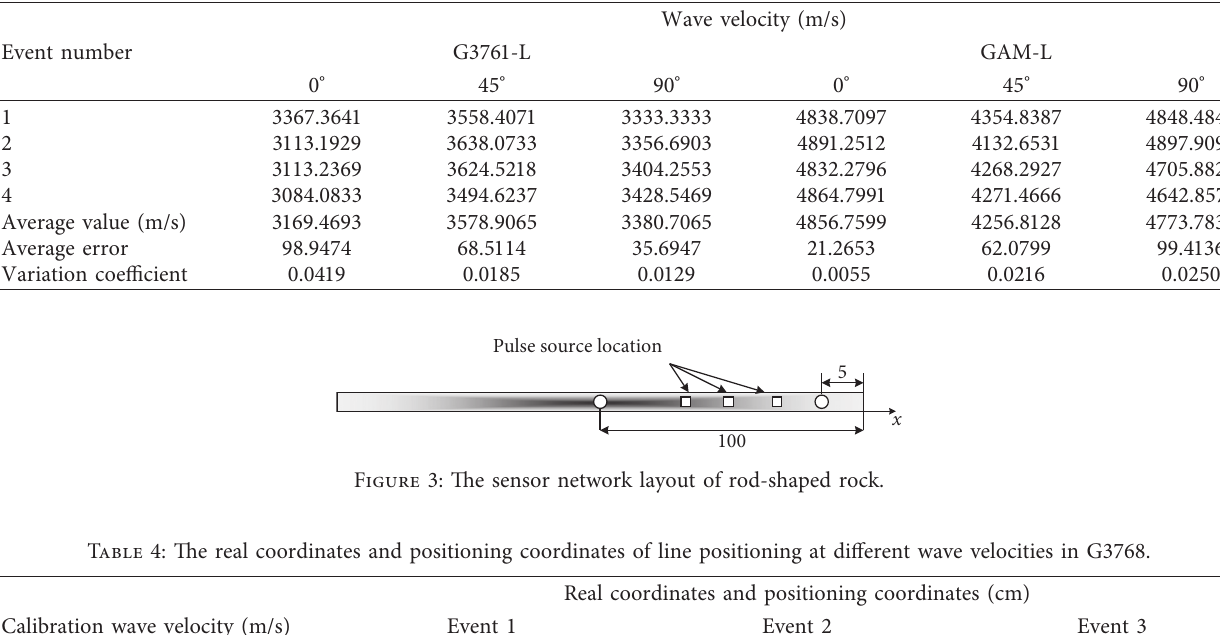
Table 3: Results of wave velocity calibration for each group of plate-shaped rock.